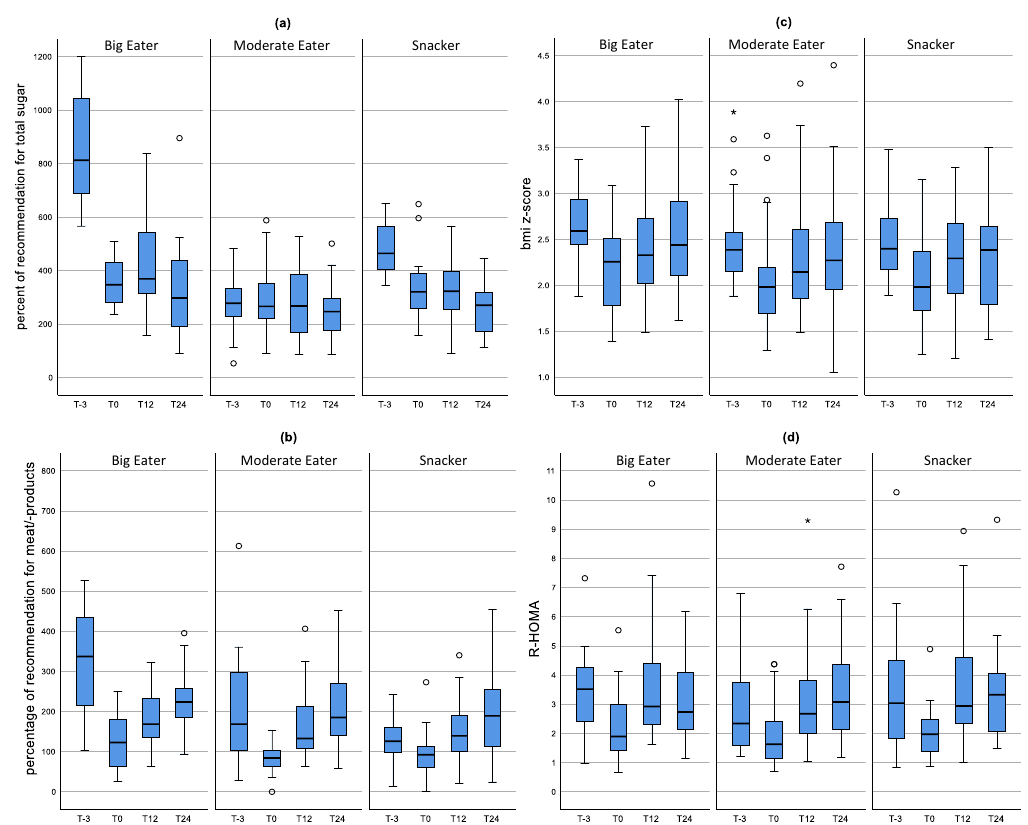
Figure 3. Distribution of consumption of meat products ( a ) and total sugar ( b ) as well as the BMI z-score ( c ) and R-HOMA ( d ) during the course of the study according to dietary patterns. Results of the mixed model. The mean value as well as the upper and lower limit are shown. Box-Whisker plots with the inner box corresponding to the interquartile range around the median and the whiskers corresponding to the 5th and 95th percentiles.